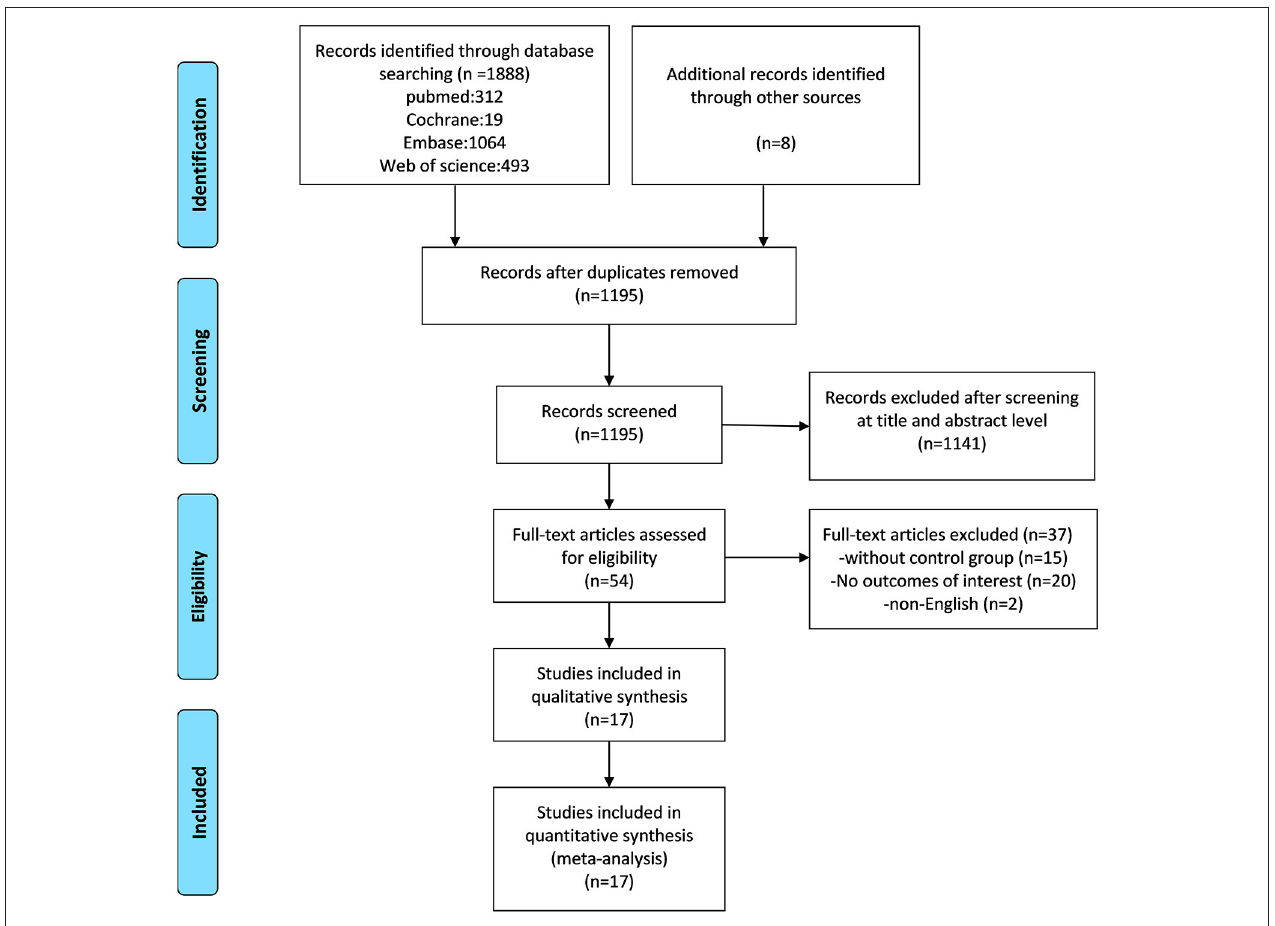
FIGURE 1 | A flow diagram of the study selection process, based on the PRISMA